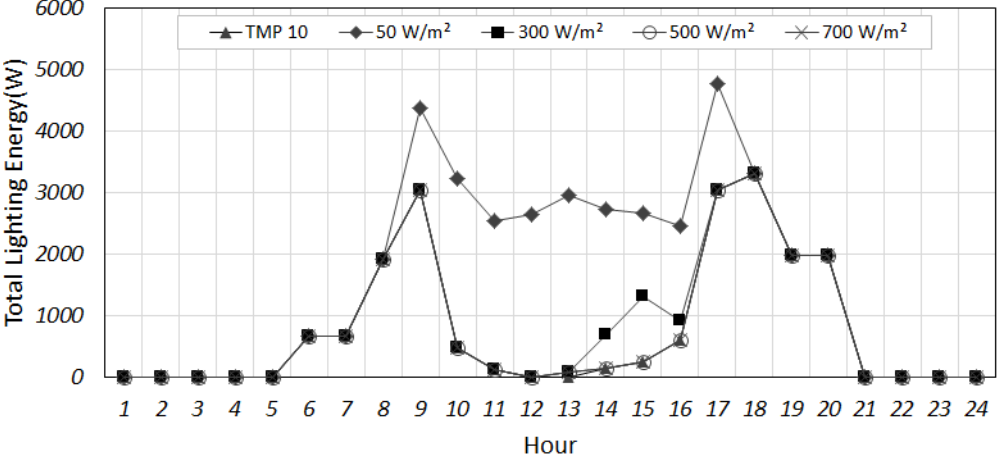
Figure 11. Lighting energy consumption of electrochromic glass on a typical winter day by controlling condition. Table 7. Lighting energy consumption of electrochromic glass on a typical winter day by controlling condition.